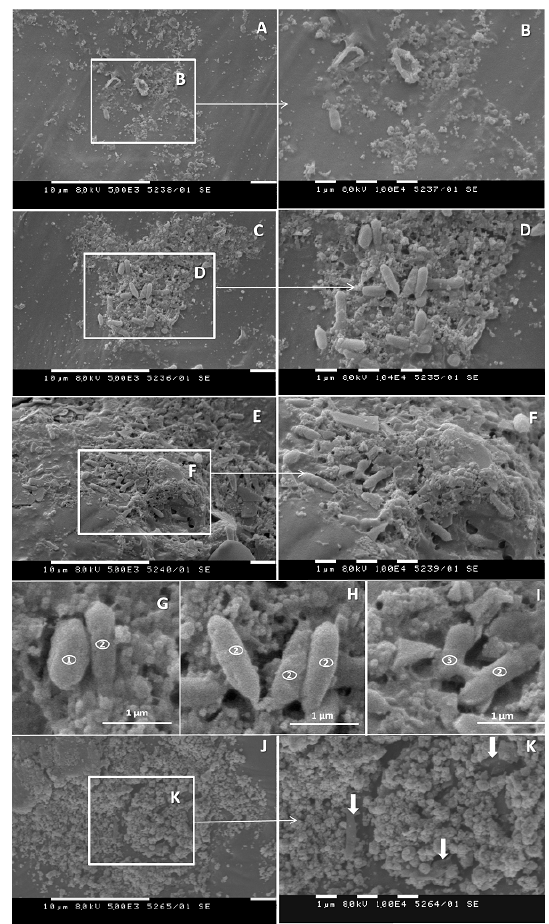
Figure 6. Biofilm formation on the surface of PCL pearls cultivated in the presence of the bacterial community. ( A – F ), 72-h of cultivation. Adherence of bacterial cells ( A , B ), formation of microcolonies ( C , D ) and an apparent penetration of bacteria into the plastic ( E , F ) is illustrated. ( G – I ) Biofilm bacteria with three distinct types of morpholiogy were present on the PCL pearls: (1) oval cells morphologically similar to those of B. thermoruber strain 7 (Figure 5D); (2) rod-like cells; (3) pyriform bacteria. ( J , K ). On week 3 areas with the presence of grain-like material predominated, and the bacterial cells were submerged under this material ( K ,